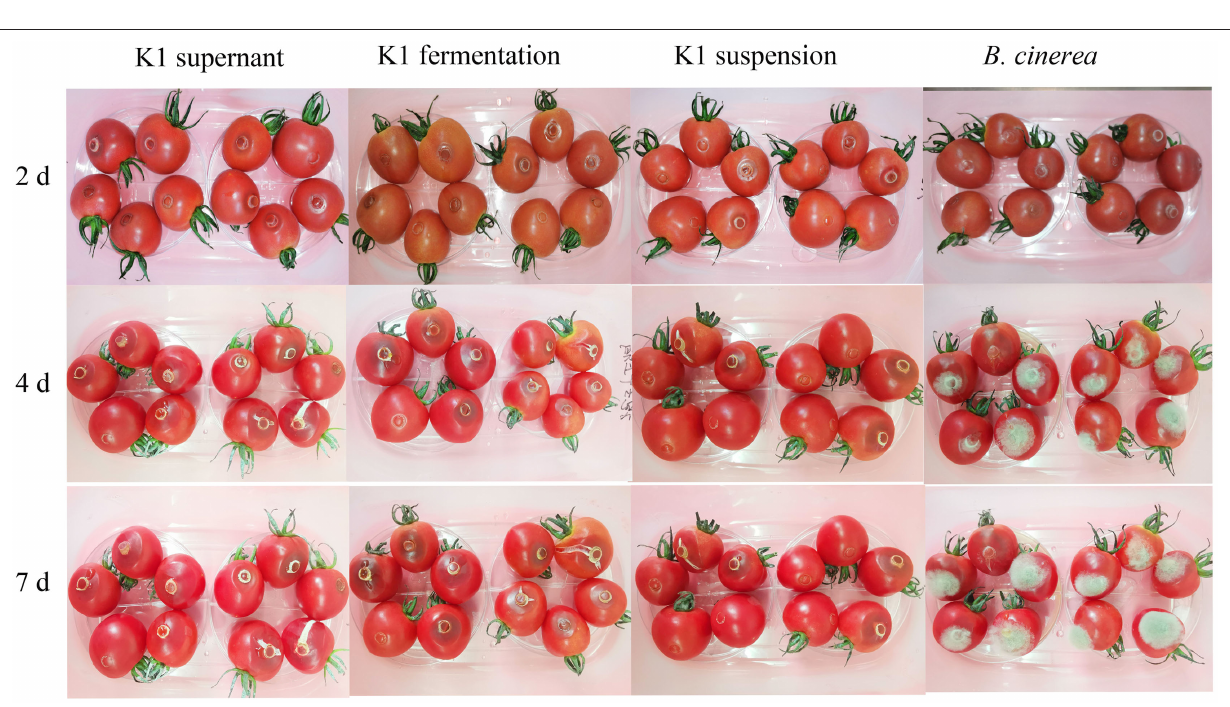
FIGURE 7 | In vivo antifungal effect evaluation of K1 culture on tomato fruit. Tomatoes were inoculated with K1 fermentation broth, supernatant, and suspension, respectively, and subsequently injected B. cinerea conidia suspension at the concentration of 10 6 . Control group were treated with B. cinerea conidia suspension (1 × 10 6 ml − 1